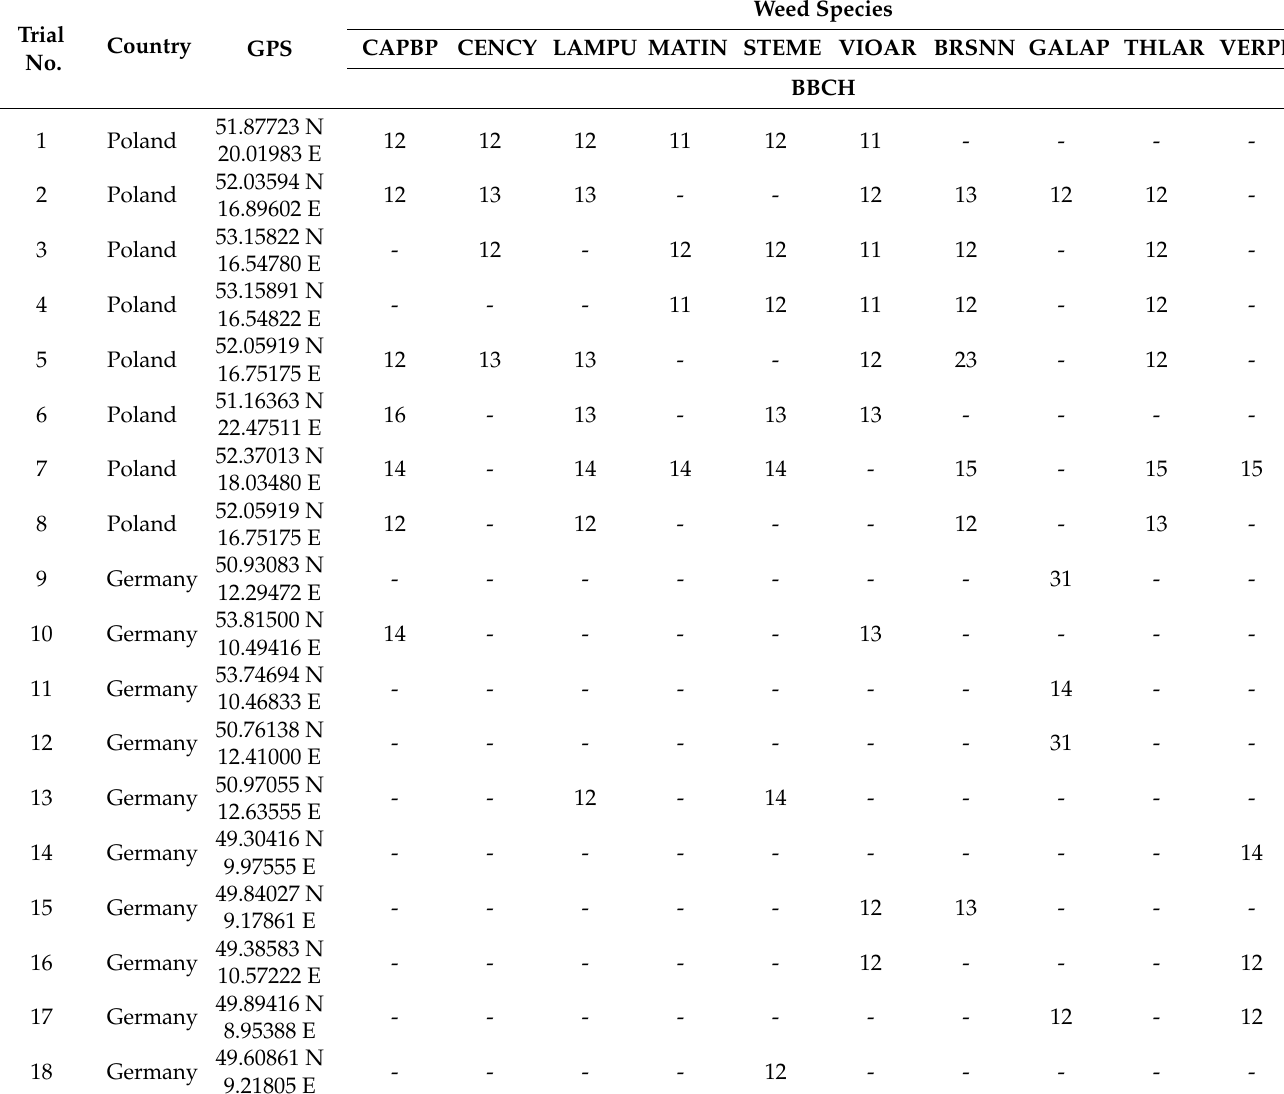
Table 2. Weed species growth stages (BBCH) during herbicide application at individual